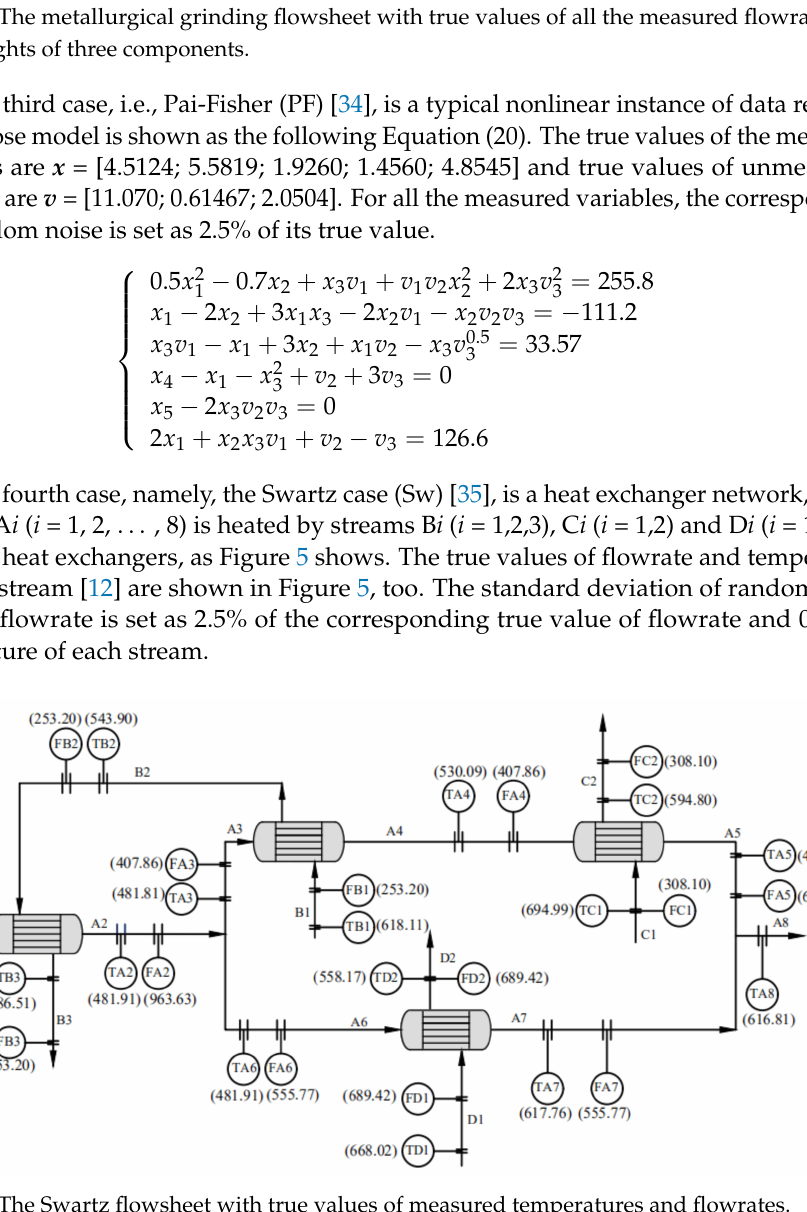
Figure 5. The Swartz flowsheet with true values of measured temperatures and